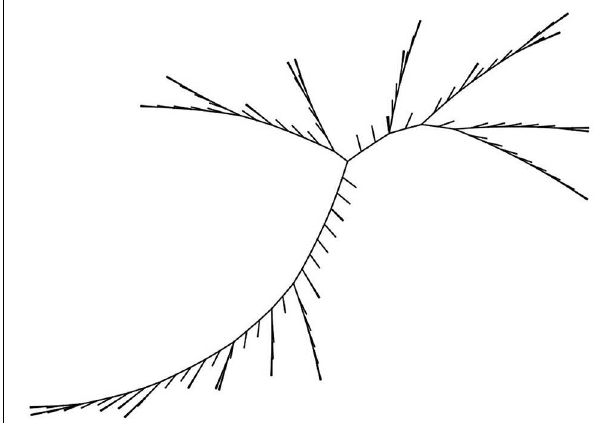
FIGURE 5 | A example tree obtained with cladistics, represented here as unrooted. When a root is chosen, the tree takes the shape of hierarchical